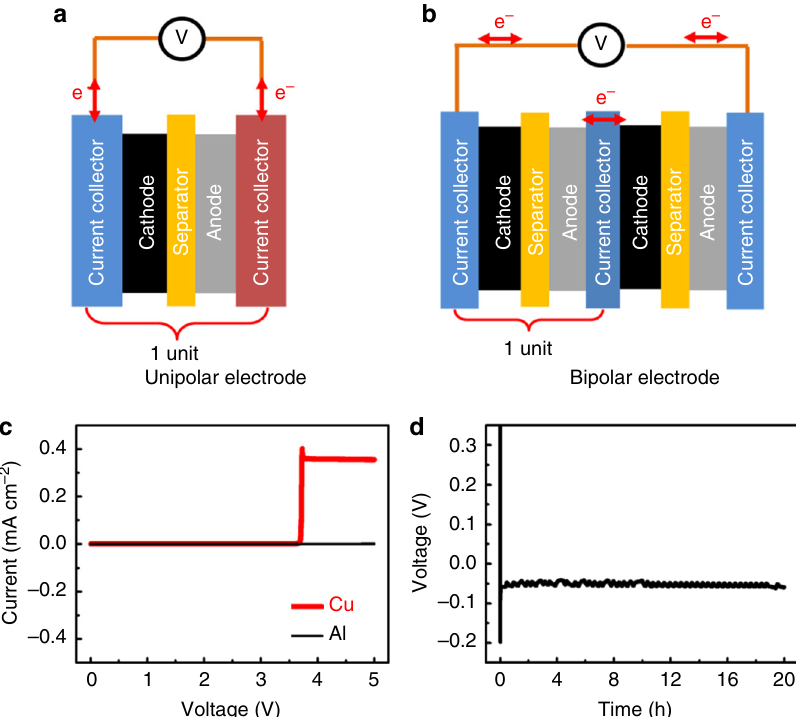
Fig. 1 Design and achievement of bipolar electrode structure. a Schematic of the conventional unipolar electrode structure (one-unit cell). b Schematic of the proposed bipolar electrode structure (two-unit cell). c Linear scanning voltammograms of Al and Cu foils as the cathodes with metallic Na as the anode at 0~5 V at a scanning speed of 0.2 mVs − 1 . d Discharge curves of Al foil as the cathode with metallic Na as the anode at 100 mA cm − 2 for 20